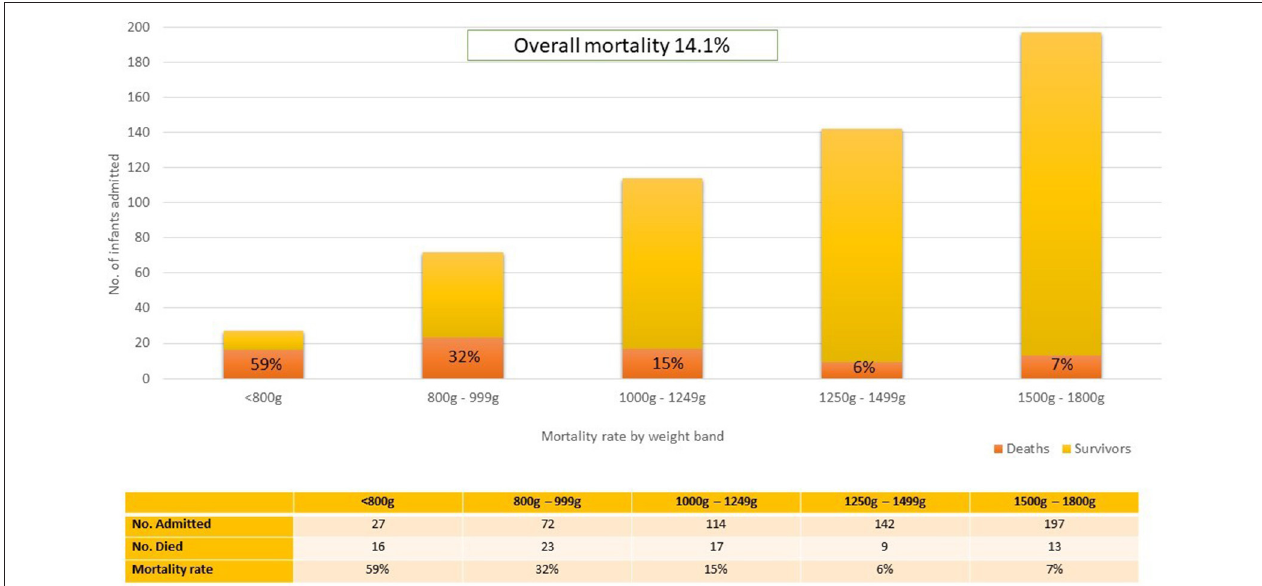
FIGURE 2 | Mortality rate stratified by weight band. The total number of infants in each weight band has been depicted to illustrate the relative burden of admissions per weight band and deaths is depicted as a proportion of the total number of admissions.